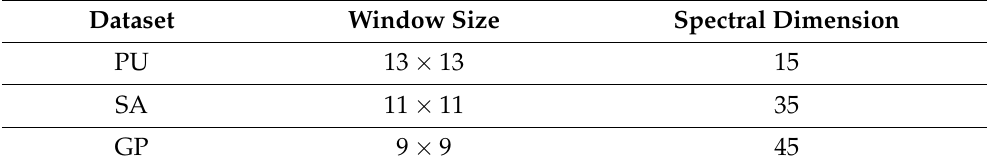
Table 5. The optimal window size and spectral dimension of the proposed model on three HSI